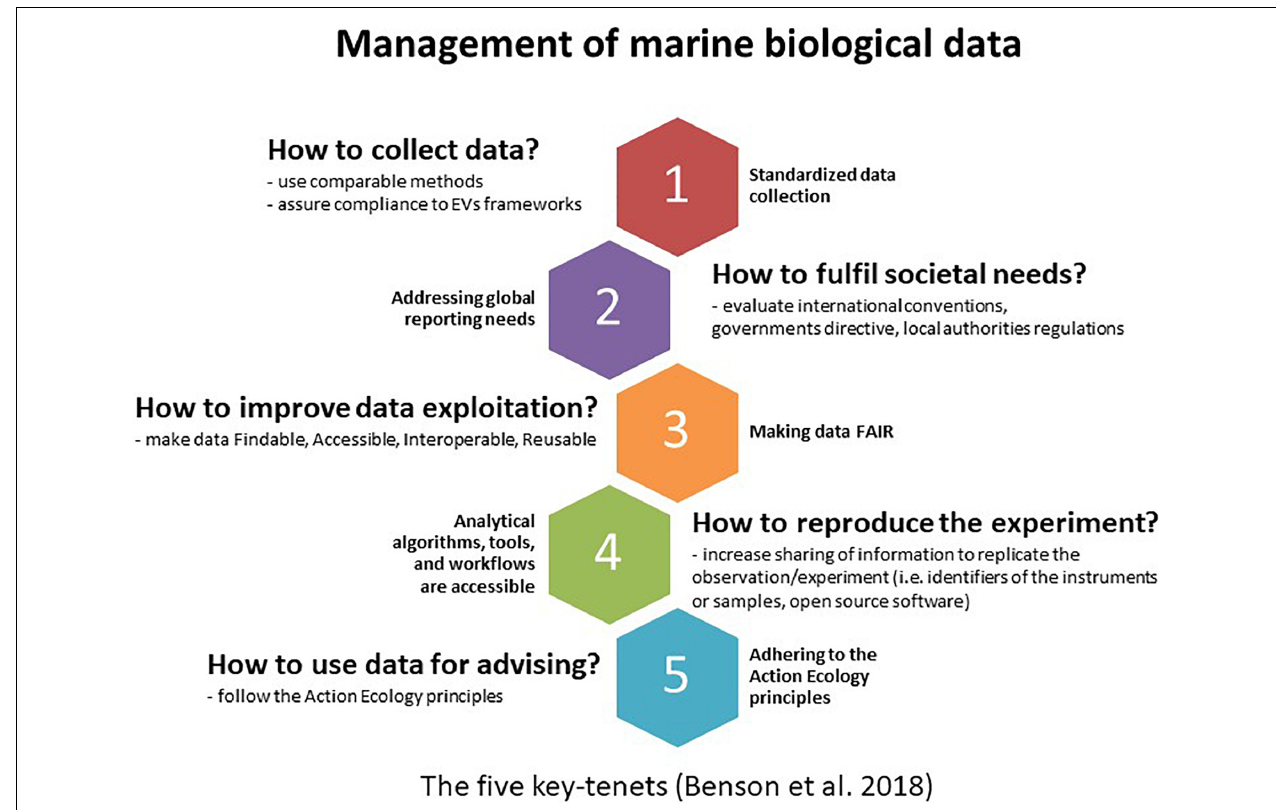
FIGURE 1 | The concept of management of marine biodiversity data addressed along with the five key-tenets envisioned by Benson et al.